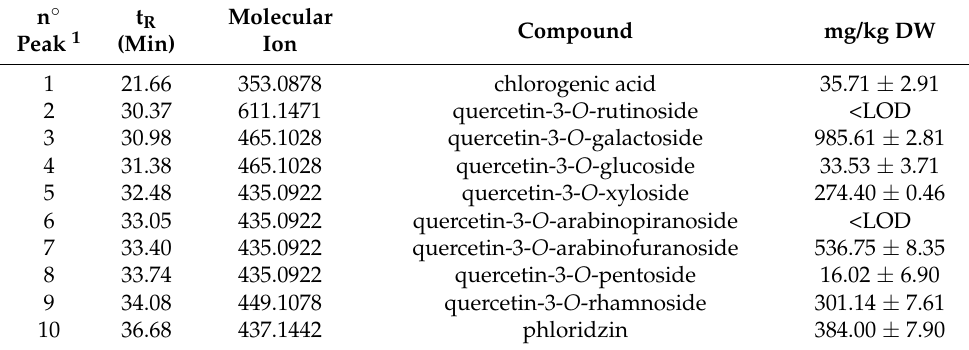
Table 4. Phenol content (mg/kg) of FD2 extract (mean values ± SD, n = 3). n ◦ t R Peak 1